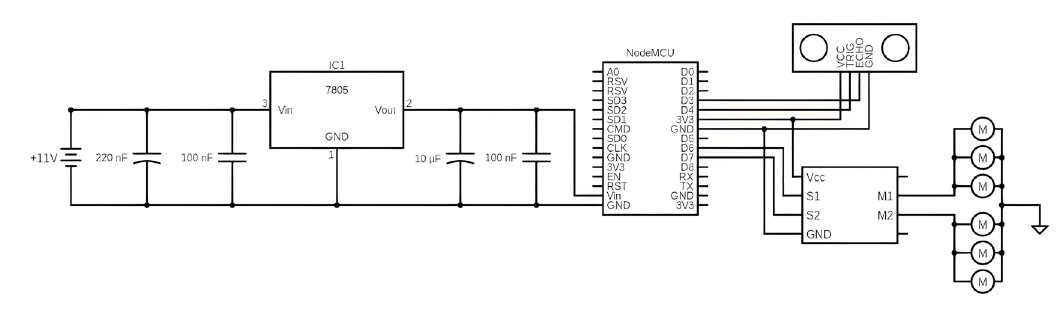
Figure 2. Circuit Diagram for Rover